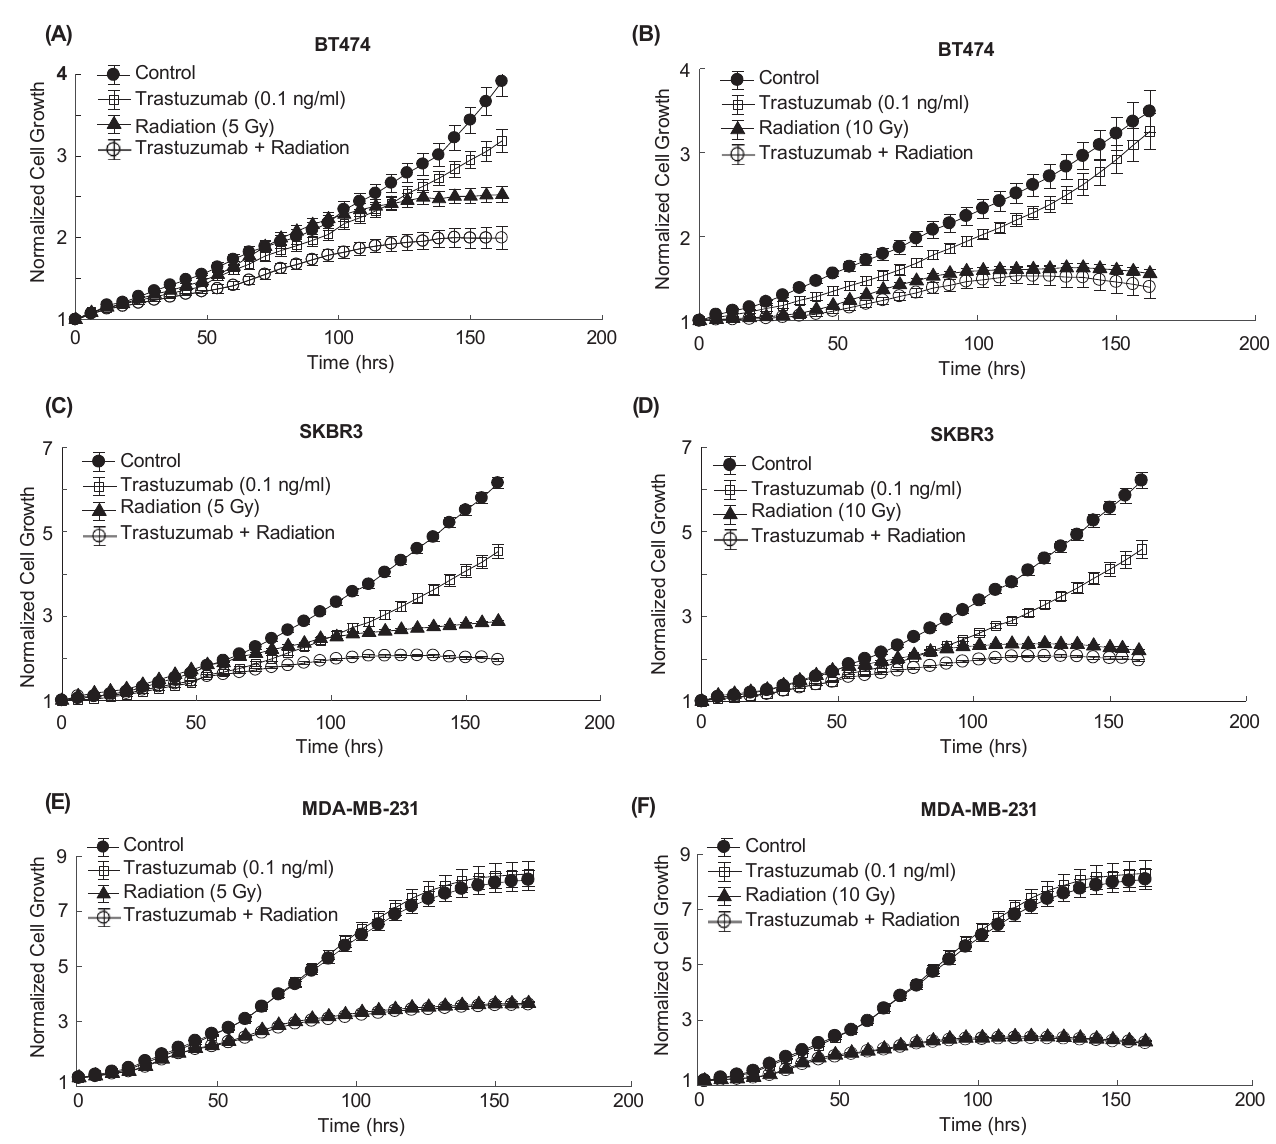
Figure 4. Cell proliferation over one week after radiation, trastuzumab, or combination treatment. All trastuzumab single-agent and combination groups were treated with 0.1 ng/mL of trastuzumab from 0–48 h. All radiation single-agent and combination groups were treated with 5 or 10 Gy radiation on Day 0. Graphs display the proliferation of: ( A ) BT474 cells after trastuzumab, 5 Gy radiation, and combination treatment, ( B ) BT474 cells after trastuzumab, 10 Gy radiation, and combination treatment, ( C ) SKBR3 cells after trastuzumab, 5 Gy radiation, and combination treatment, ( D ) SKBR3 cells after trastuzumab, 10 Gy radiation, and combination treatment, ( E ) MDA-MB-231 cells after trastuzumab, 5 Gy radiation, and combination treatment, and ( F ) MDA-MB-231 cells after trastuzumab, 10 Gy radiation, and combination treatment. No significant difference was observed in the control MDA-MB-231 cell proliferation and cells treated with single-agent trastuzumab ( p = 0.88, ( E , F )). No significant difference in cell proliferation was observed between cells treated with single-agent radiation and cells treated with combination treatment ( p = 0.84, ( E ) and p = 0.80, ( F )).